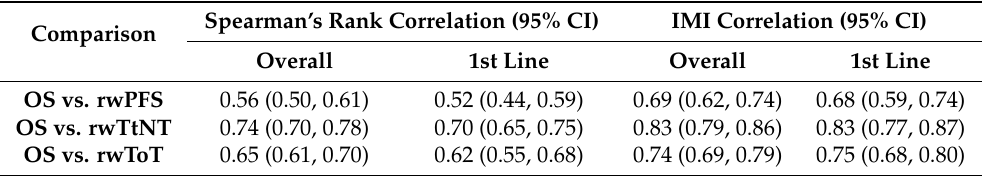
Table 3. Correlations among real-world outcome